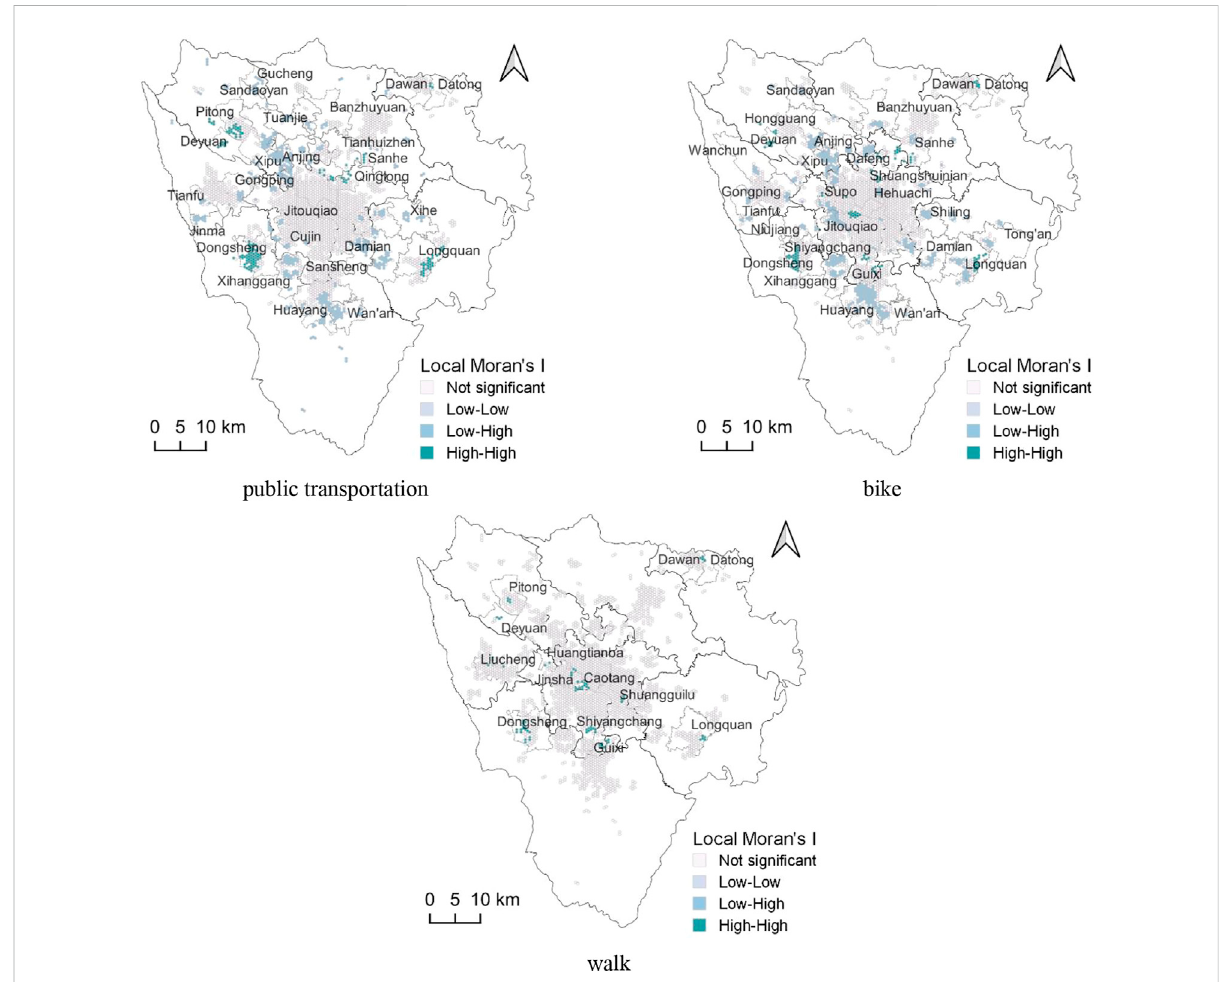
FIGURE 11 Partial clustering of park accessibility by public transportation, bike, and